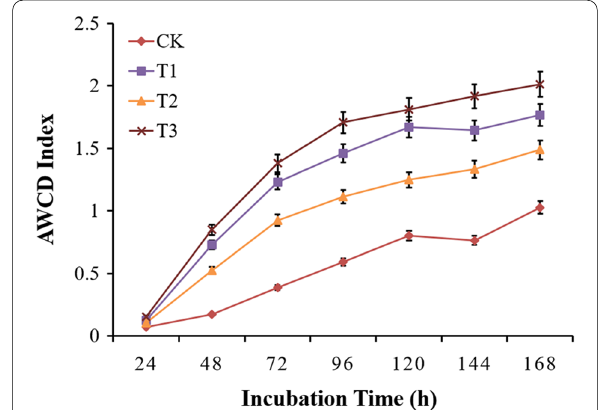
Fig. 6 Average well color development (index) of soil microbial diversity under different treatments after particular hours of incubation. Significant difference among the treatments is shown by Duncan’s multiple range test at P <